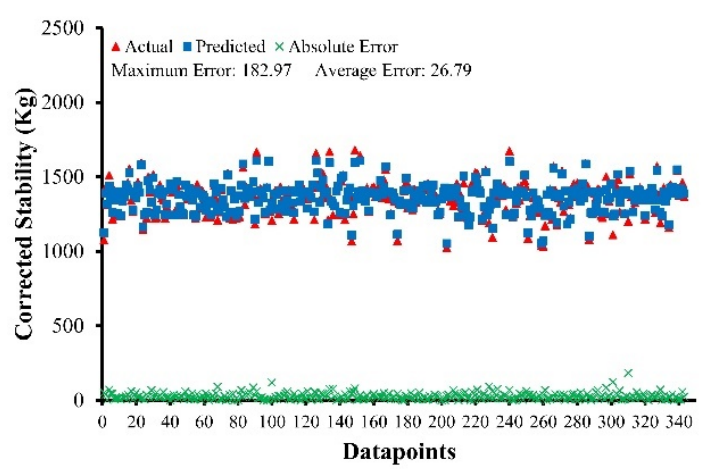
Figure 6. Absolute errors of ABC–MF.